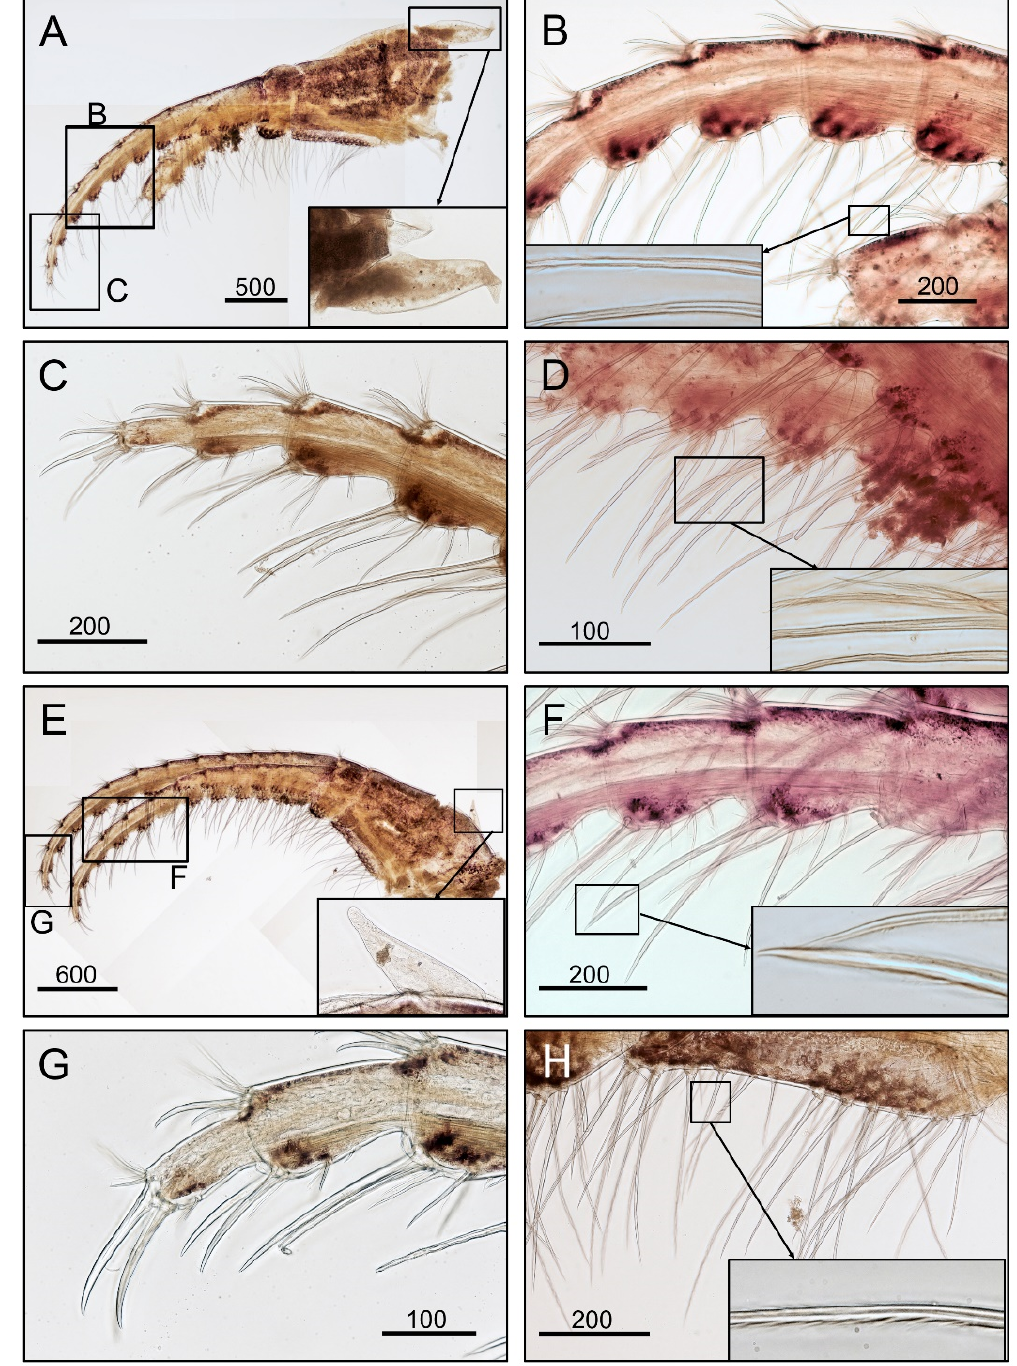
Figure 3. Conchoderma virgatum . ( A ) Cirrus III, note single filamentary appendage at base, anterior ramus broken. ( B ) Intermediate segments of posterior ramus, showing serrulate setae. ( C ) Distal segment of posterior ramus. ( D ) Magnified segment of anterior ramus of cirrus III, showing serrulate setae. ( E ) Cirrus IV, showing small filamentary appendage at base. ( F ) Simple-type setae at cirrus IV. ( G ) Distal end of posterior ramus of cirrus IV, showing short robust simple setae. ( H ) Intermediate segment of cirrus IV, showing serrulate setae. Scale bars in μ m.